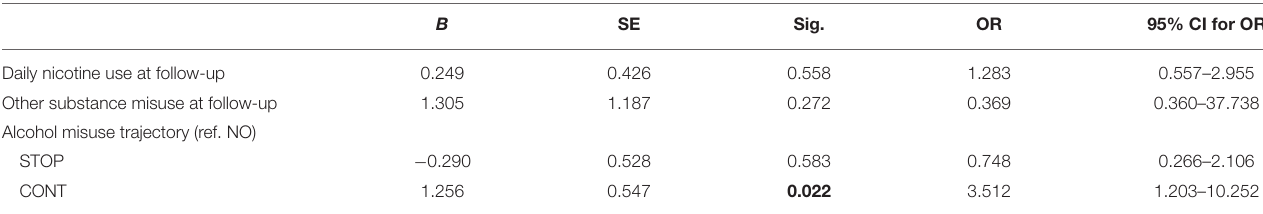
TABLE 5 | Prediction of “any relapse” with alcohol misuse